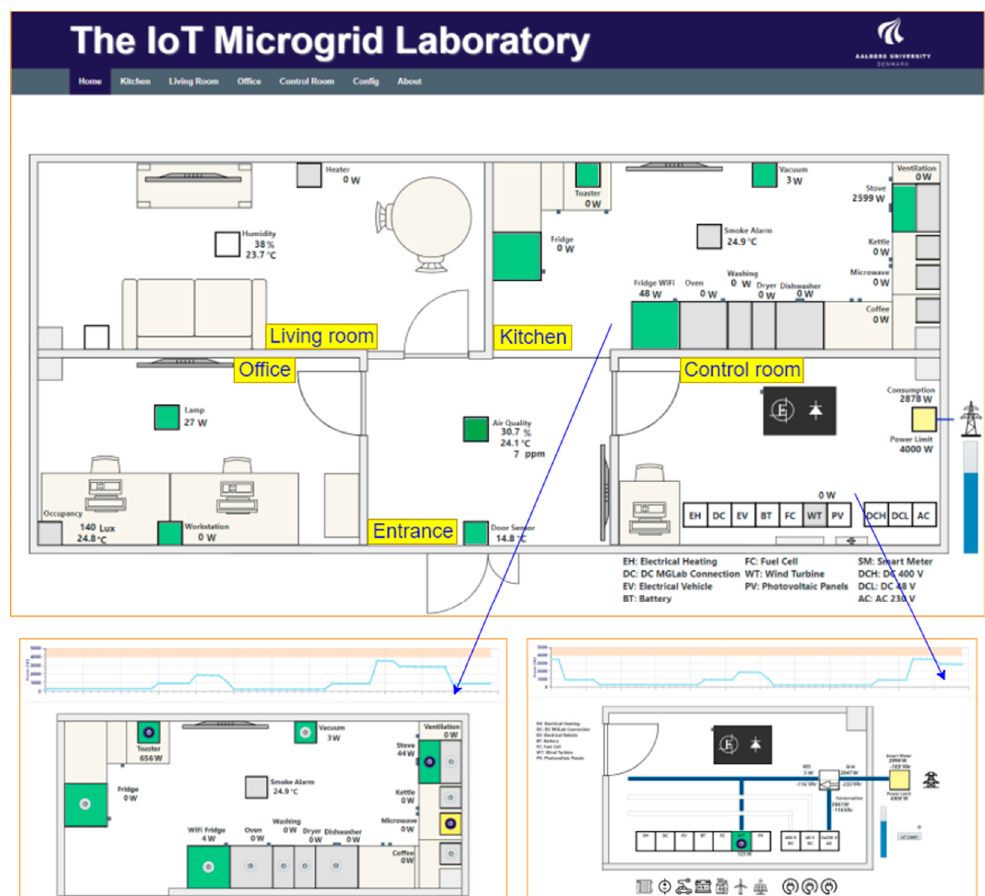
Figure 10. The web interaction interface of IoT-MGLab.